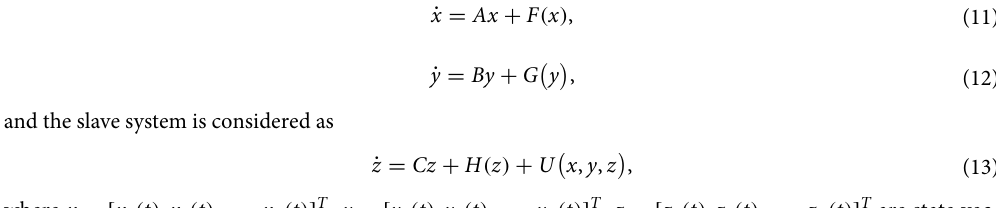
Difference synchronization of chaotic systems